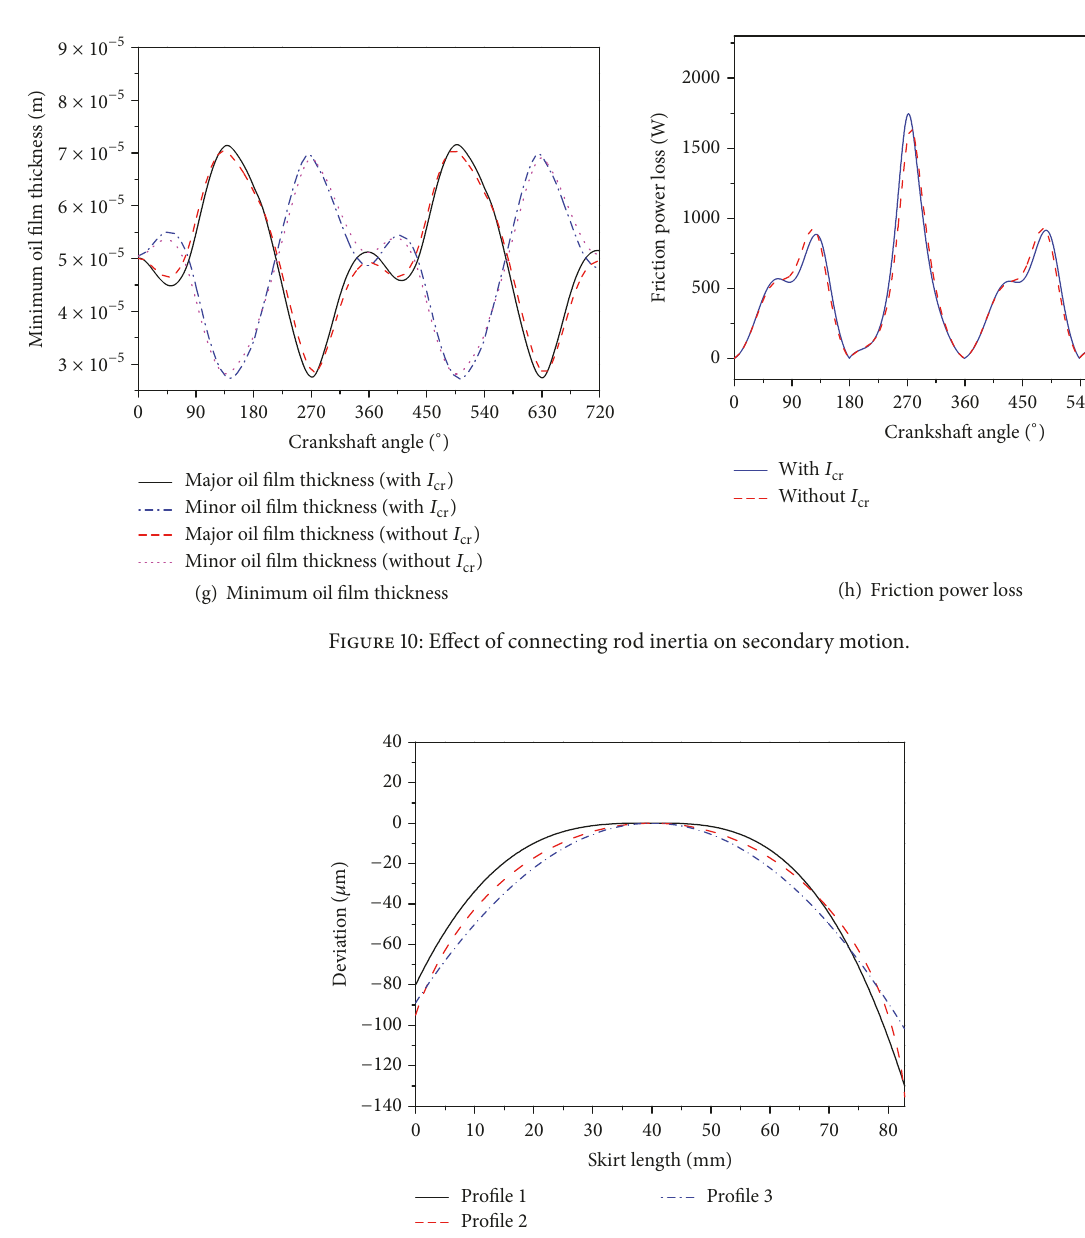
Figure 11: Profiles of different longitudinal profile